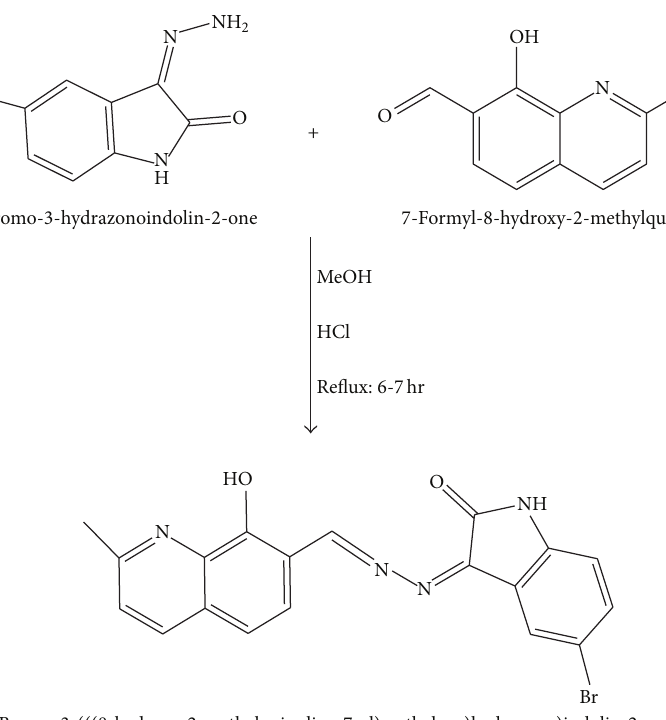
Figure 1: Schematic representation of Schiff base (BHMQMHI).